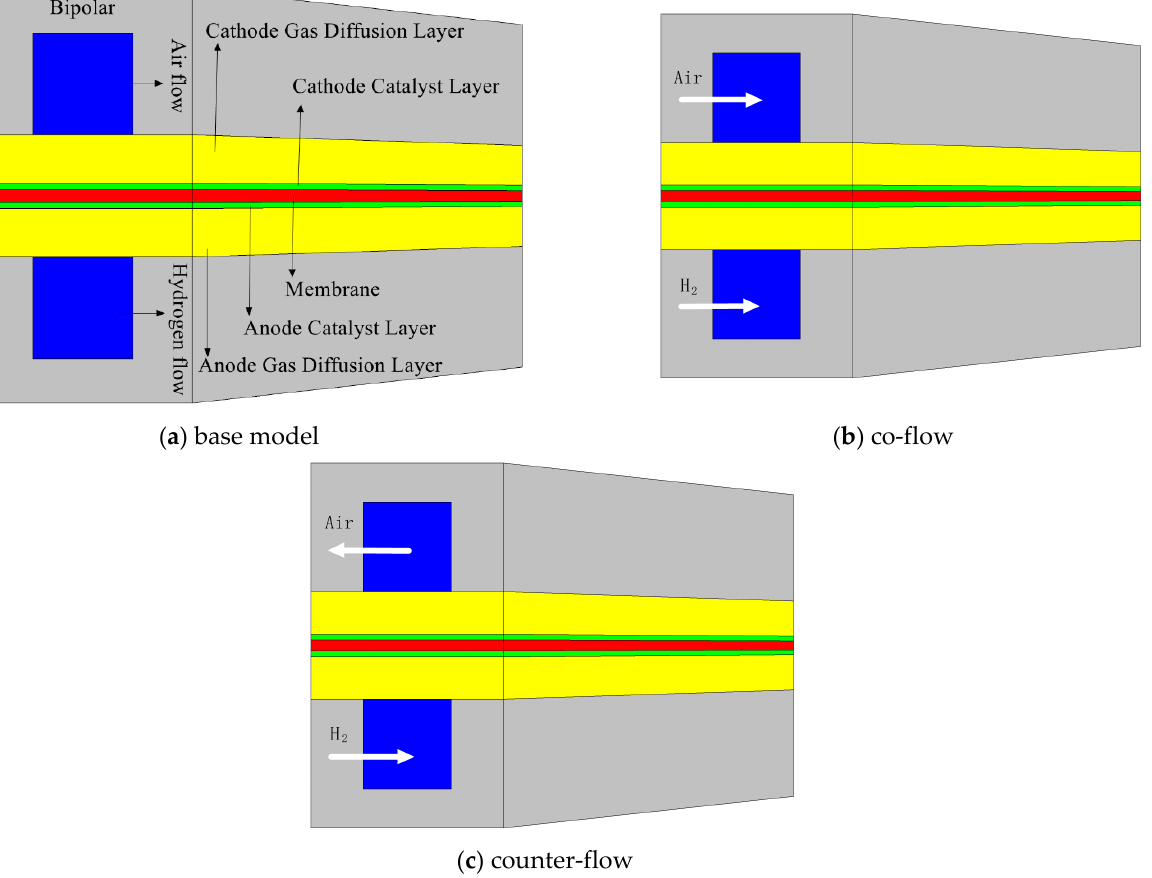
Figure 1. Base model and flow patterns.